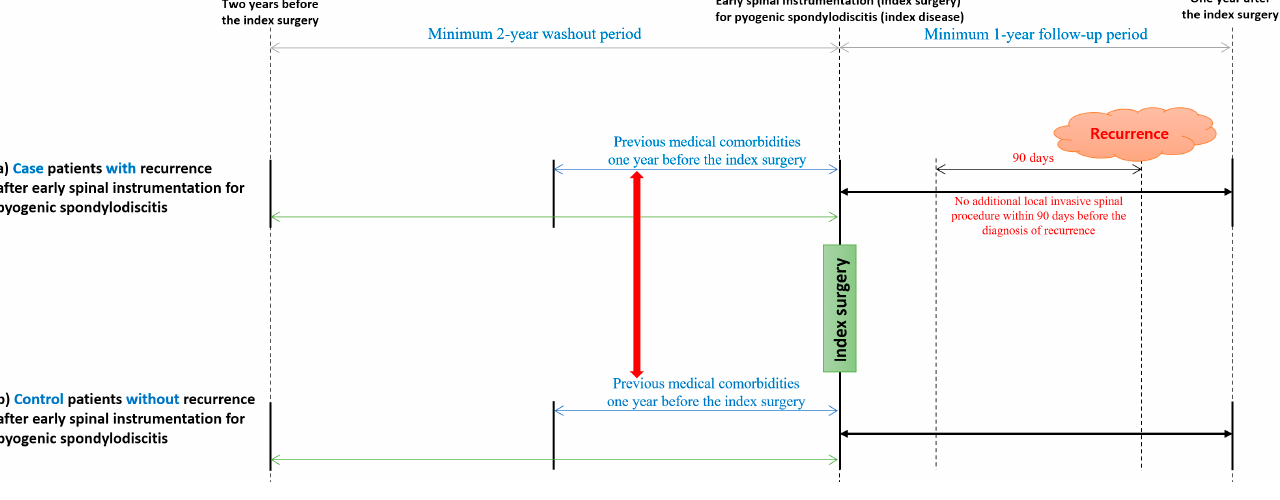
Figure 1. Definitions of cases and controls.